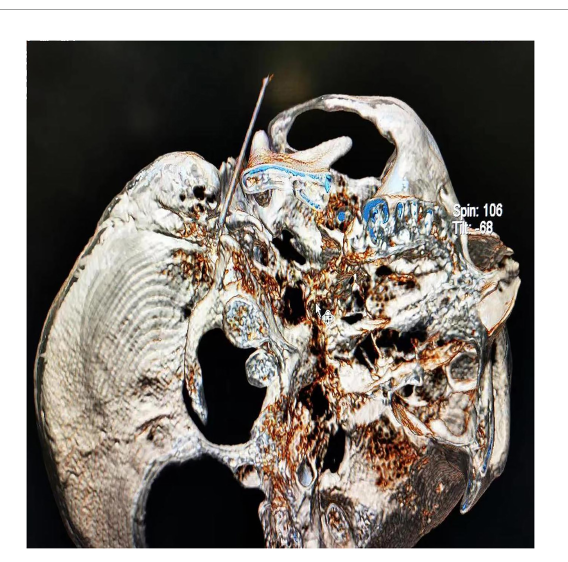
FIGURE4 Three-dimensional reconstruction of the CT scans confirmed successful puncture of the stylomastoid foramen.